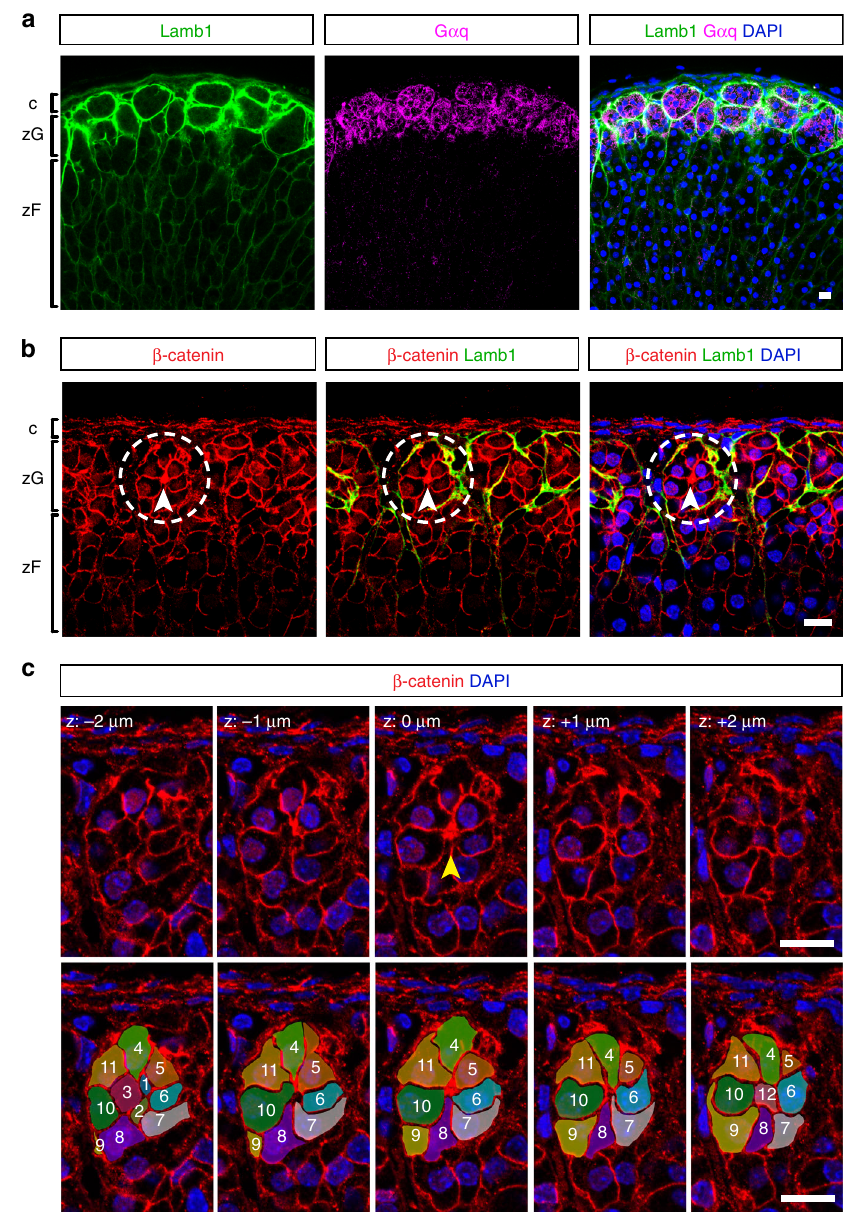
Fig. 1 Adult adrenal glomeruli consist of multicellular rosettes. a Laminin β 1 (Lamb1, green) marks the basement membrane surrounding distinct clusters of zG cells (G α q + , magenta), de fi ning the outline of individual glomerulus. b Cells within each glomerulus organize into rosettes. Representative image of an adult adrenal slice stained for Laminin β 1 (Lamb1, green) and β -catenin (red). Dashed circles highlight a rosette example. Arrowheads point to rosette center. c Top, confocal z-stack images of the rosette encircled in ( b ), showing β -catenin (red) and nuclei (DAPI, blue). Z step size is 1 μ m. Arrowhead points to the rosette center. Bottom, tracing of cells (pseudo-colored and numbered 1 – 12) participating in the rosette shown in top panel. c capsule, zG zona glomerulosa, zF zona fasciculata. DAPI (blue) marks nuclei. All bars, 10 μ